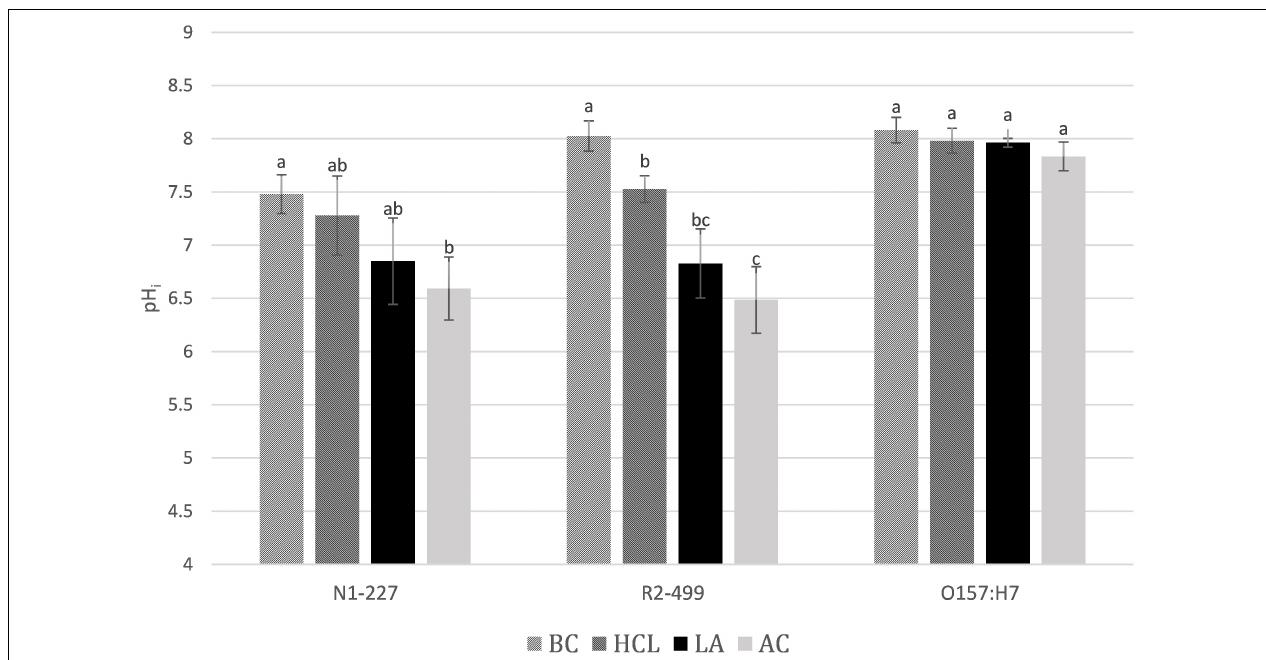
FIGURE 2 | Average pH i after 1 h. pH i values of Listeria monocytogenes N1-227, L. monocytogenes R2-499, and Escherichia coli O157:H7 after 1 h in habituation treatment media. Error bars represent standard error of the mean. Treatment details: BC, baseline control (TSB pH 7.4); HCl, pH control (TSB adjusted to pH 6.0 with HCl); LA, lactic acid treatment (TSB adjusted to pH 6.0 with HCl containing 4.75 mM lactic acid); AC, acetic acid treatment (TSB adjusted to pH 6.0 with HCl containing 4.75 mM acetic acid). Superscripts identify significant differences within